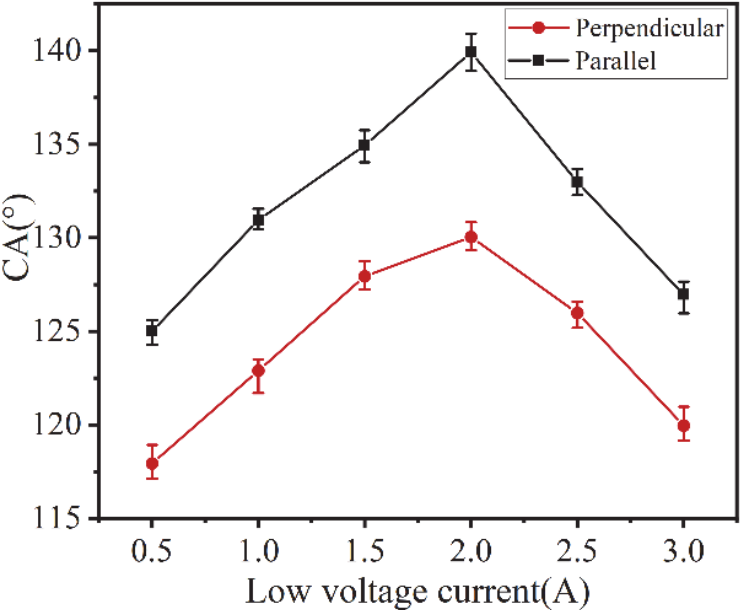
Figure 7. Contact of the CA of the surface of the macro-micro composite structure processed by different low-voltage electric currents.